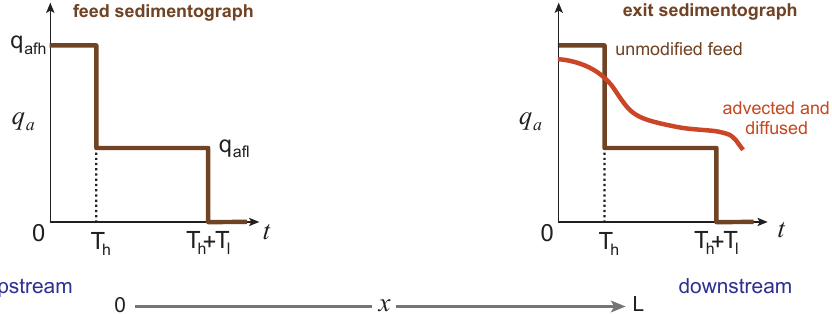
Figure 2. Schematic diagram illustrating downstream modification of a sedimentograph. At the upstream feed point ( x =0, left panel), the bedload transport rate q a takes the high feed value q afh for time T h and the low feed value q afl time T l , for a total cycle time of T = T h + T l . At the downstream end ( x = L , right panel), the discontinuous brown line represents the unaltered sedimentograph at the downstream end of the reach, assumed to have propagated instantaneously from the supply point, while the smoother red line represents the sedimentograph as modified by advective–diffusive effects.